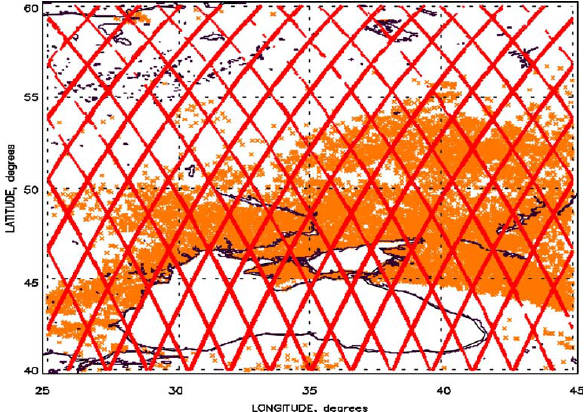
Fig. 1. Active fires as seen by MODIS during July and August 2006, 2007, 2008 for the Western Russian and Eastern Europe area. CALIPSO overpasses during the same time period are superim- posed.